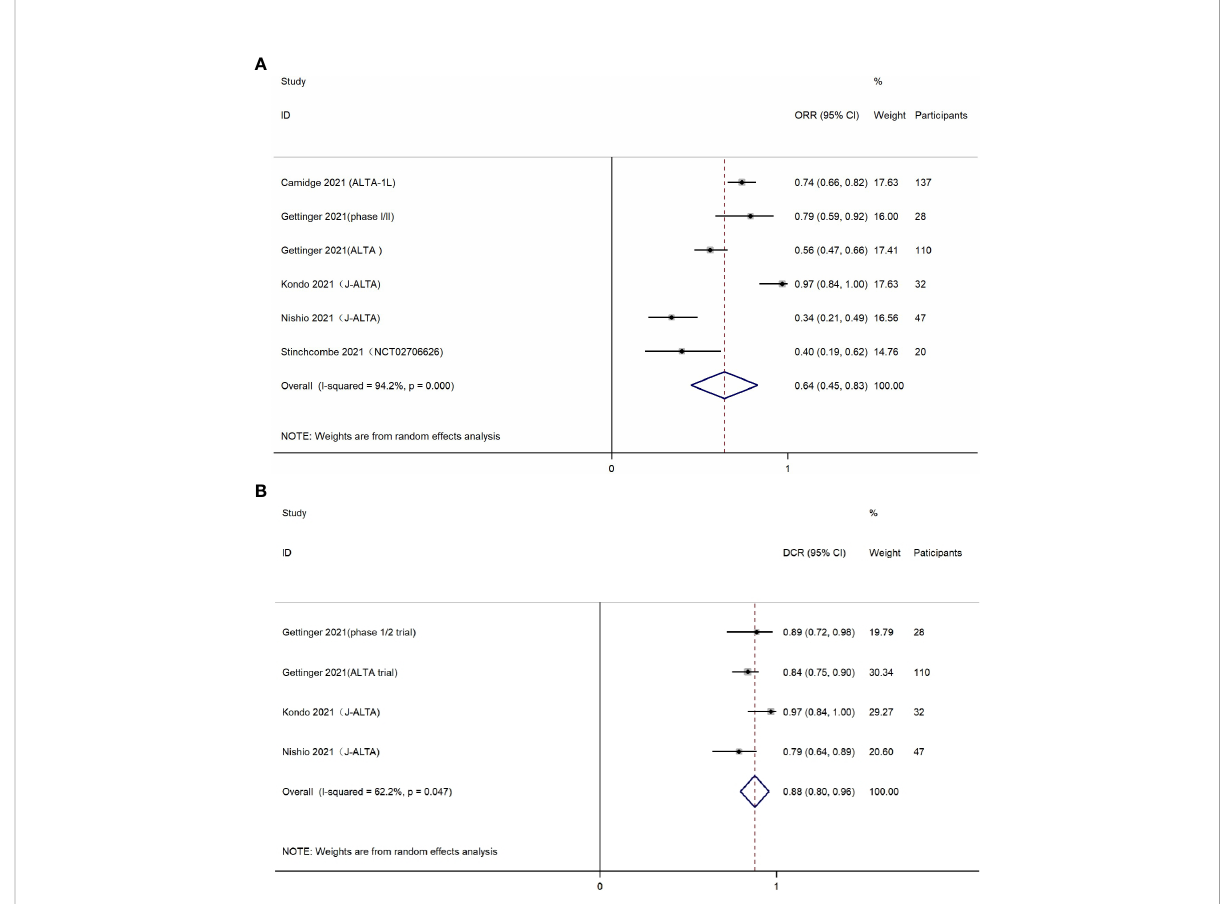
Figure 7). Statistical tests for funnel plot asymmetry, both Begg ’ s test and Egger ’ s test, did not detect statistically signi fi cant asymmetry for all effect size evaluated, except iPFS ( P =0.022) (Supplemental Table